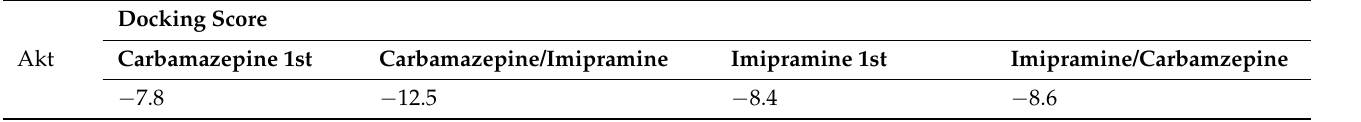
Table 1. Dockings scores for carbamazepine, imipramine alone and co-bound in Akt.